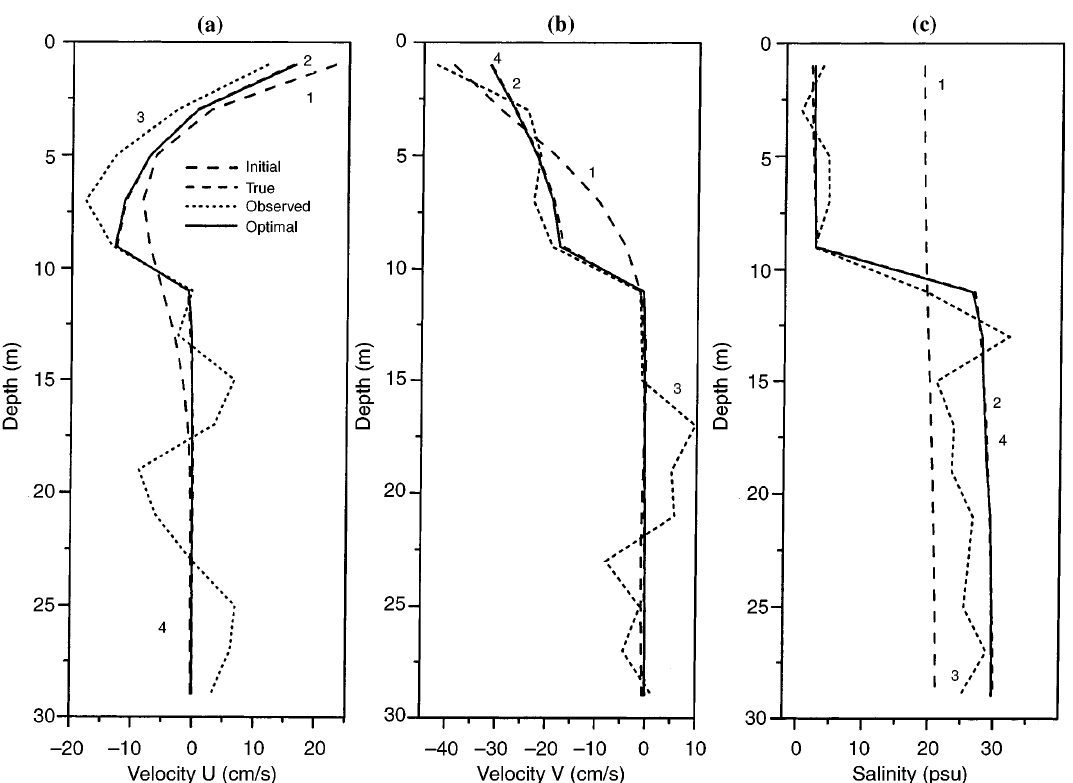
Fig. 6a–c. Velocity u a , velocity v b and salinity c profiles at t (cid:136) 48h. 1 , Profiles from the initial simulation computed with a constant turbulent viscosity (cid:133) m t (cid:136) 10cm 2 (cid:1) s (cid:255) 1 (cid:134) . 2 , True profiles. 3 , Assimilated